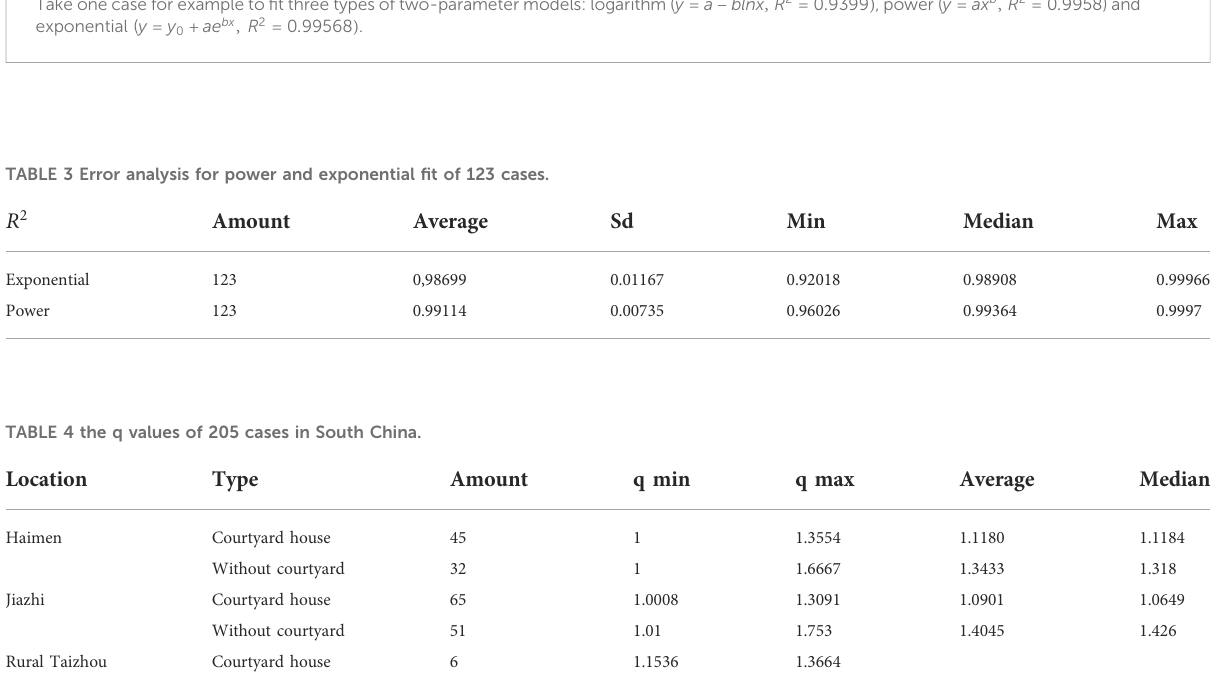
FIGURE 4 Take one case for example to fi t three types of two-parameter models: logarithm ( y (cid:2) a − blnx , R 2 (cid:2) 0 . 9399 ) , power ( y (cid:2) ax b , R 2 (cid:2) 0 . 9958) and